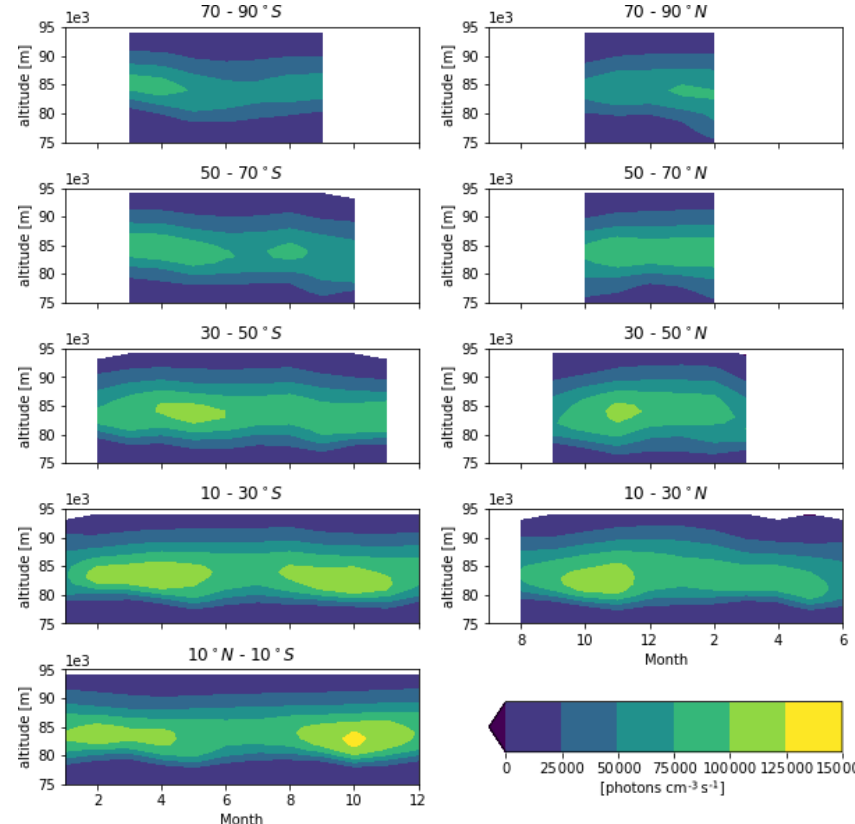
Figure 8. Monthly mean zonal average volume emission rate (VER) of all available years. Note that the Northern Hemisphere plots have been shifted by 6 months to ease comparison between the